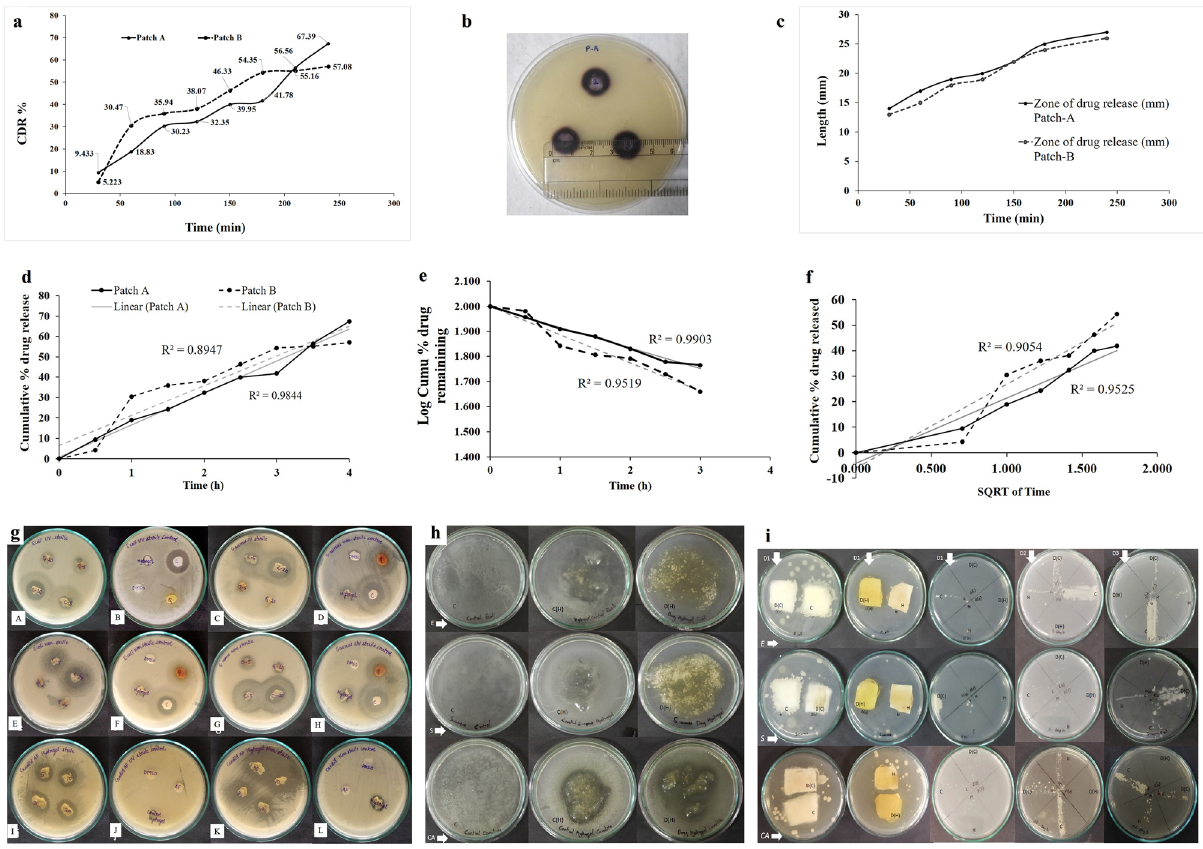
Figure 3. Mathematical modelling for transdermal drug delivery system: Time-dependent evaluation of salicylic acid release from GbH: ( a ) graphical illustration of spectrophotometric analysis of controlled drug release profile of patch-A and -B for salicylic acid; ( b ) illustration of agar well diffusion test for controlled drug release profile of patch-A and -B; ( c ) graphical illustration of controlled drug release profile of patch-A and -B for salicylic acid agar well diffusion test. Mathematical model representation of drug release from GbH: ( d ) zero-order, ( e ) first-order and ( f ) Higuchian release kinetics. Agar diffusion of GbH: ( g.A ) UV-sterile GbH performance against E.coli; ( g.B ) Control plate of UV-sterile GbH performance against E.coli ; ( g.C ) UV-sterile GbH performance against S. aureus; ( g.D ) Control plate of UV-sterile GbH performance against S. aureus ; ( g.E ) Non-sterile GbH performance against E.coli; ( g.F ) Control plate of non-sterile GbH performance against E.coli ; ( g.G ) Non-sterile GbH performance against S. aureus; ( g.H ) Control plate of non-sterile GbH performance against S. aureus ; ( g.I ) UV-sterile GbH performance against C. albicans ; ( g.J ) Control plate of UV-sterile GbH performance against C. albicans ; ( g.K ) Non-sterile GbH performance against C. albicans and ( g.L ) Control plate of non-sterile GbH performance against C. albicans . ( h ) illustrate agar overlay performance of GbH where E, S and CA denote E. coli, S. aureus and C. albicans, respectively; C denotes Control plate; C(H) denotes positive control GbH; D(H) denotes test drug-loaded GbH. ( i ) illustrates patch agar performance of GbH where D1, D2 and D3 are Day 1, 2 and 3, respectively; E, S and CA denote E. coli, S. aureus and C. albicans, respectively; C denotes Cotton patch; D(C) denotes drug-loaded cotton patch; H denotes GbH and D(H) denotes drug-loaded